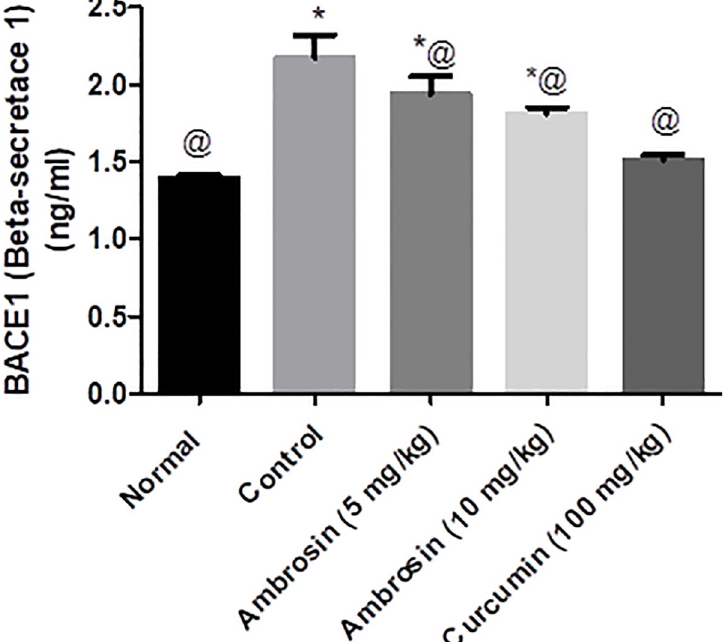
Fig 6. Curcumin and ambrosin abated the elevation in BACE1 levels after LPS administration. Data represented mean ± SEM (n = 6). Statistical analysis was performed using one-way ANOVA followed by Tukey‘s multiple comparison test. � Significantly different from normal group at P < 0.05. @ Significantly different from control group at P < 0.05.